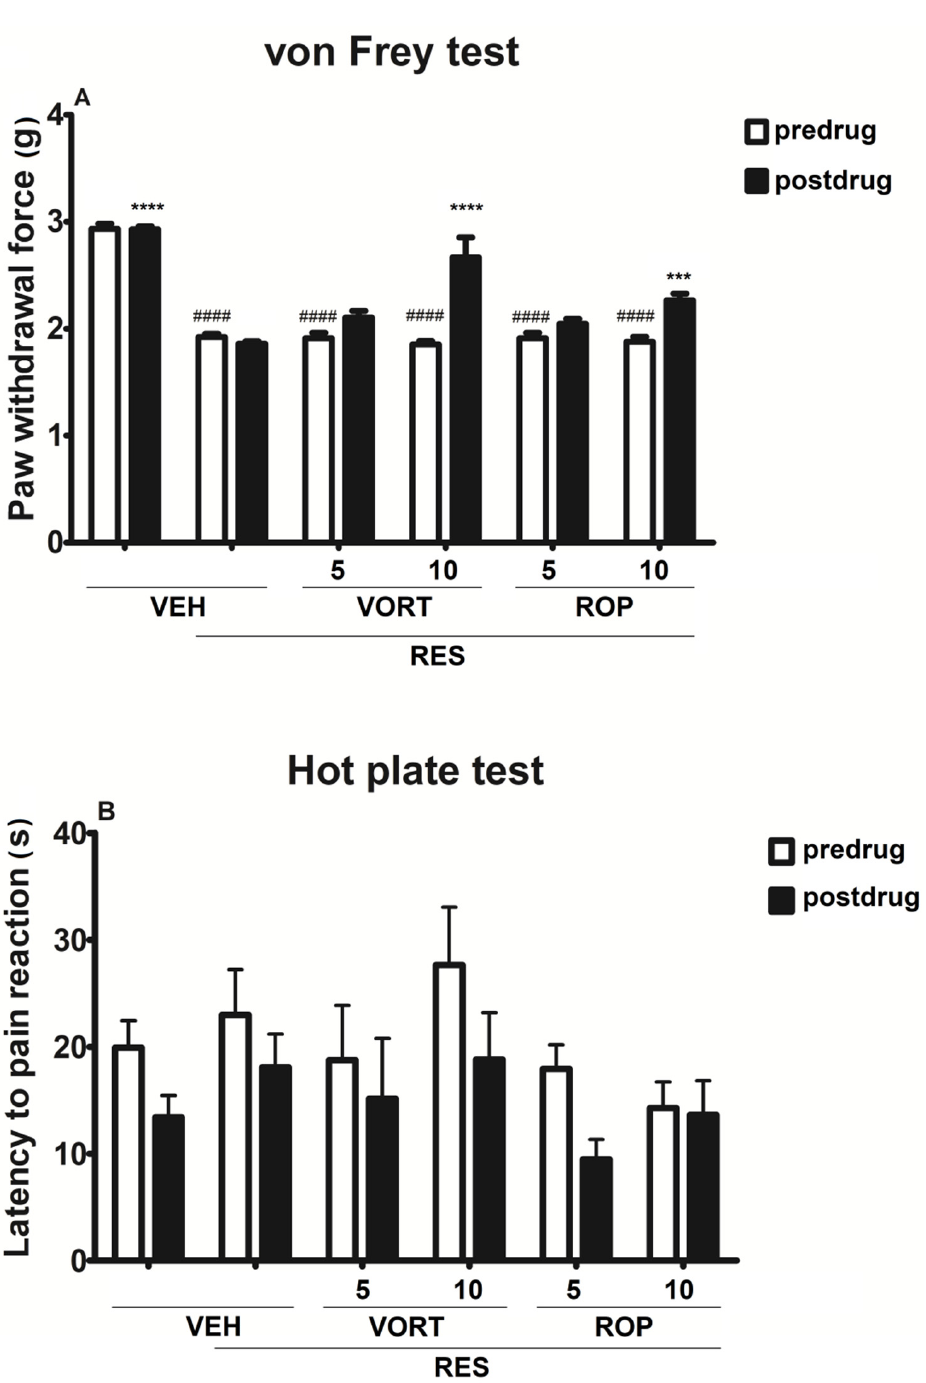
Figure 2. Antiallodynic and antihyperalgesic activities of intraperitoneally administered vortioxetine (VORT; 5 and 10 mg/kg) and ropinirole (ROP; 5 and 10 mg/kg) in the mouse FM-like model induced by a 3-day administration of subcutaneous reserpine (RES; 0.25 mg/kg). The effect of test drugs on tactile allodynia was measured in the von Frey test ( A ) and their effect on heat hyperalgesia was measured in the hot plate test ( B ) 1 h after drug administration. Results are shown as the mean paw withdrawal threshold (g) ( A ), or the mean latency to pain reaction (s) ( B ) ± SEM for n = 10. Statistical analysis: repeated measures analysis of variance, followed by Tukey’s post hoc comparison. Significance vs. predrug paw withdrawal of VEH group: #### p < 0.0001 and significance vs. postdrug paw withdrawal of RES + VEH group: *** p < 0.001, **** p < 0.0001.